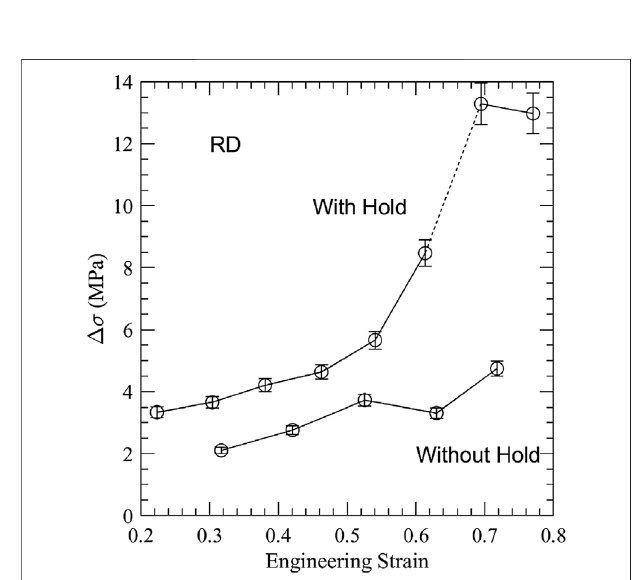
FIGURE5| Changeinyieldingofa304stainlesssteelduringinterrupted tensile testing performed at room temperature and a strain rate of 0.001 s − 1 , with and without an isothermal hold between straining